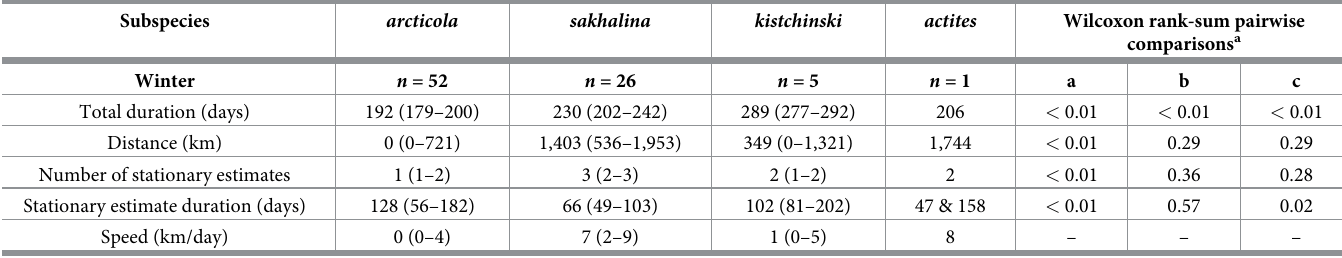
Table 3. Winter characteristics for each subspecies of Dunlin on the East Asian-Australasian Flyway. Reported is the median value and interquartile range.